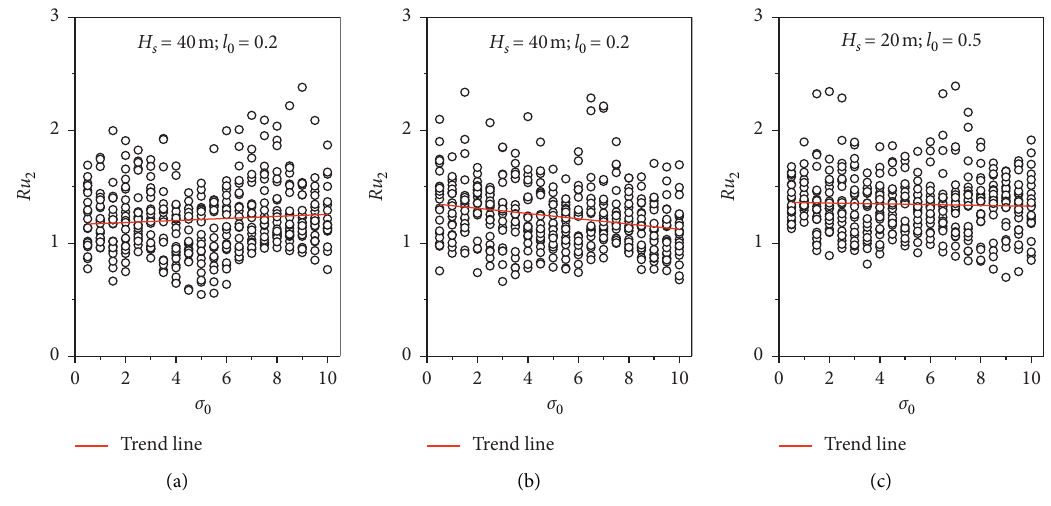
Figure 19: The parameters Ru